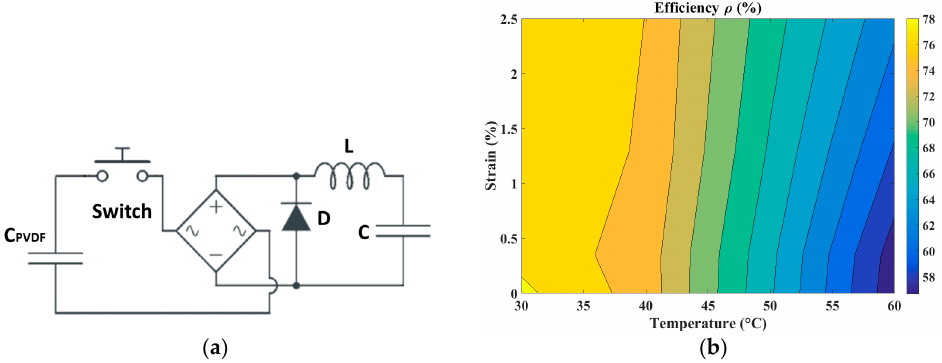
Figure 4. ( a ) Power management circuit [1], and ( b ) efficiency as function of temperature and